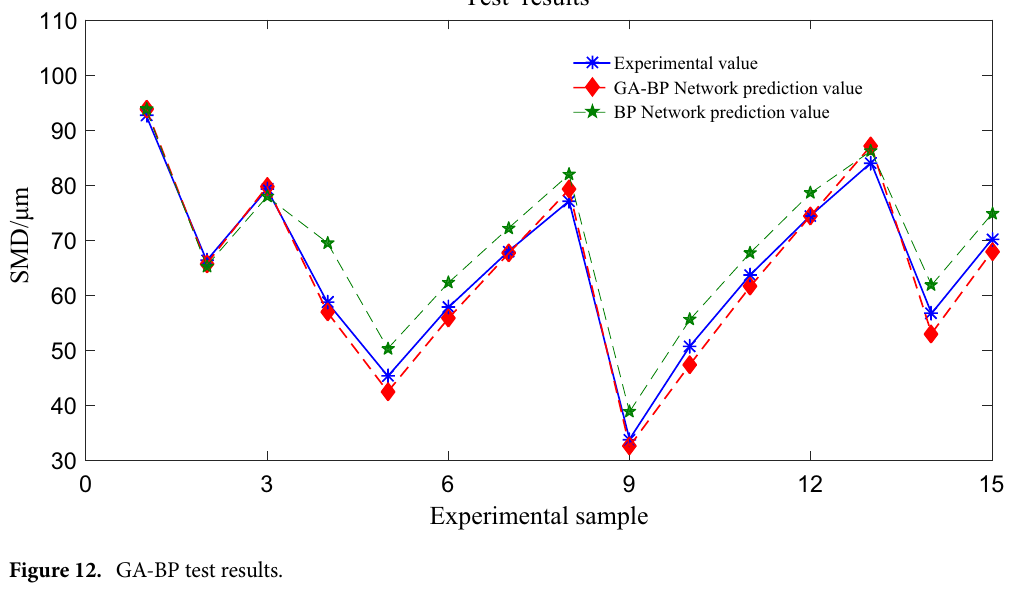
Figure 12. GA-BP test results.